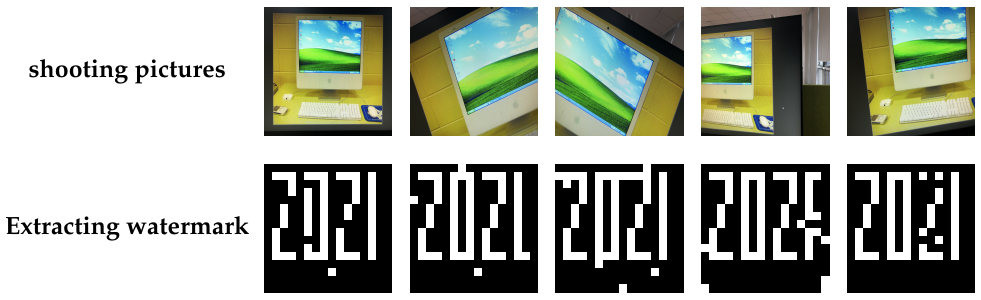
Figure 10. Watermark extraction performance for partial